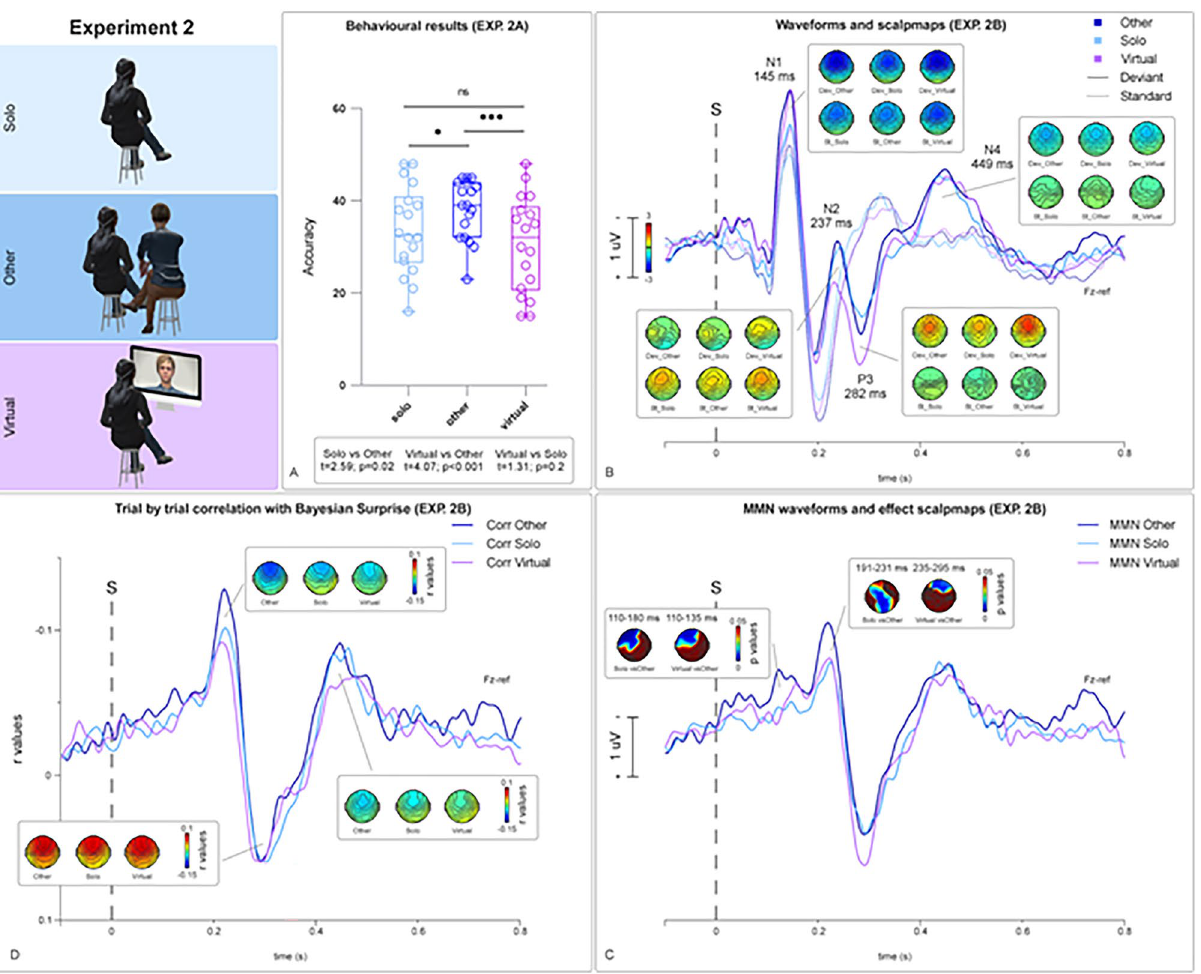
Figure 3. Whisker Plots in ( A ) depict behavioural results from Experiment 2a corresponding to the Solo (light blue), Virtual (purple) and Other (blue) conditions. Dots represent single subjects’ mean accuracies. Panel ( B ) shows average waveforms and peak amplitudes distribution on the scalp for relevant components (N1, N2, P3, N4) from Experiment 2b. Dotted and solid lines represent average ERPs corresponding to Standard and Deviant trials respectively. MMN differential waveforms are displayed in ( C ) (bottom-right) and show a negative peak at approximately 210 ms post-onset. Scalpmaps represent p values from point-by-point t-tests ( Solo vs. Other ; Virtual vs. Other ), corresponding to the effect peak latency of significant time clusters ( Solo vs. Other : 110– 180 ms and 191–231 ms; Virtual vs. Other : 110–135 ms and 235–295 ms) surviving permutation testing. Panel ( D ) (left-bottom) represents average r values from the point-by-point correlation analysis. Correlation between Bayesian Surprise and trial-by-trial amplitudes peaked at 210 ms post onset, corresponding to the MMN peak latency. Human figures in panel A were created with the Adobe software Mixamo (https:// www. mixamo. Trial‑by‑trial correlation with Bayesian surprise. As in Experiment 1, the trial-by-trial correlation analy- sis between single trial amplitudes and Bayesian Surprise indicated that r values peaked over fronto-central electrodes at three different latencies, similarly for the Other , Solo and Virtual conditions (Fig. 3d). Significant clusters corresponded to the latencies of the MMN, the N2-P3a complex and the N4 components of the audi- tory evoked potential. At Fz, results from the trial-by-trial correlation analysis performed on EEG responses following the presentation of the three conditions, Other , Solo and Virtual intervals evidenced three significant clusters (i.e. r values significantly differed from the constant 0). For the Other condition: 59–249 ms ( p < 0.001; t = − 9.27); 264–347 ms ( p < 0.001; t = 4.88); 405–522 ms ( p < 0.001; t = − 5.84). For the Solo condition: 129–247 ms ( p < 0.001; t = − 6.71); 265–362 ms ( p < 0.001; t = 5.66); 407–497 ms ( p < 0.001; t = − 5.78). For the Virtual condi- tion: 129–236 ms ( p < 0.001; t = − 5.72); 257–336 ms ( p < 0.001; t = 8.52); 419–555 ms ( p < 0.001; t = − 4.18). These results confirmed our prediction, indicating that MMN indexes Bayesian perceptual learning in our study. Fur- thermore, and in accordance with data from the literature, we also found a correlation between model updating following surprising stimuli and the P3 and N400 components 55,56 . MMN results. ERPs elicited during the Other , Solo and Virtual conditions intervals over Fz are reported in Fig. 3b. Grand-average waveforms were similar to Experiment 1 and comparable with previous studies on audi-